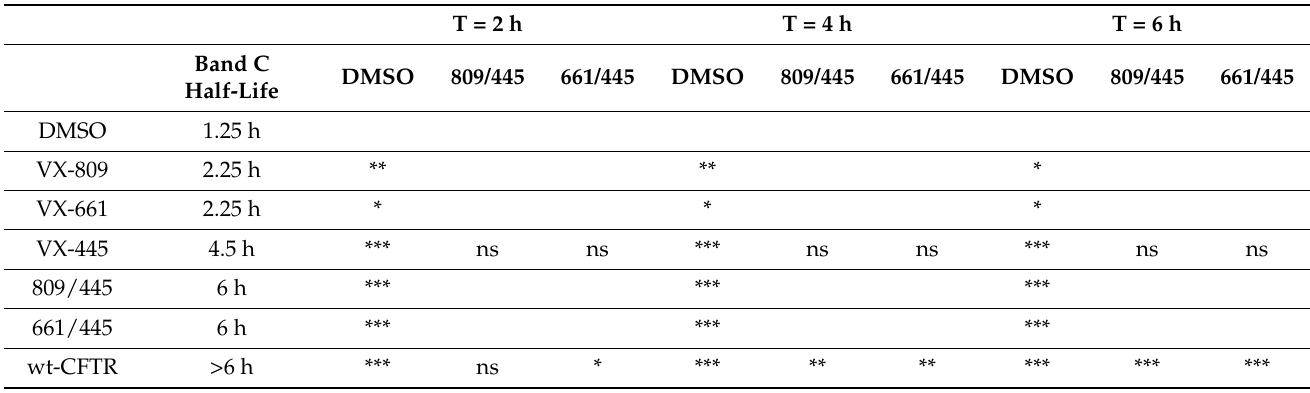
Table 1. Estimated half-life of mutant CFTR following rescue by single or double corrector treatment.